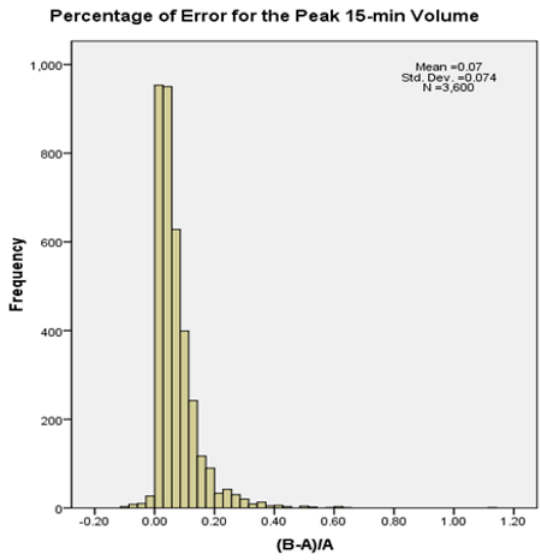
Figure 5. Comparison of Percentage Error between B and A